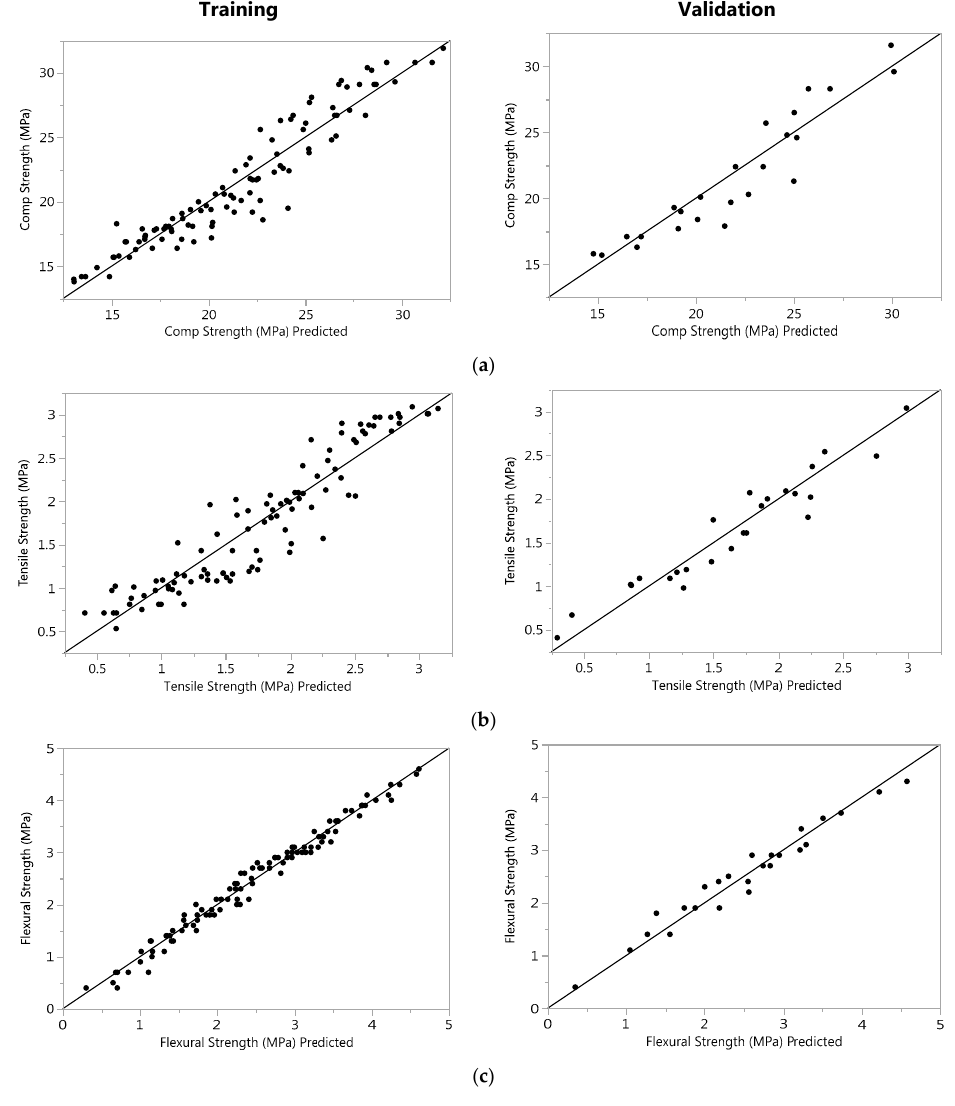
Figure 7. Training and validation plots for: ( a ) compressive strength; ( b ) tensile strength; and ( c ) flexural strength.